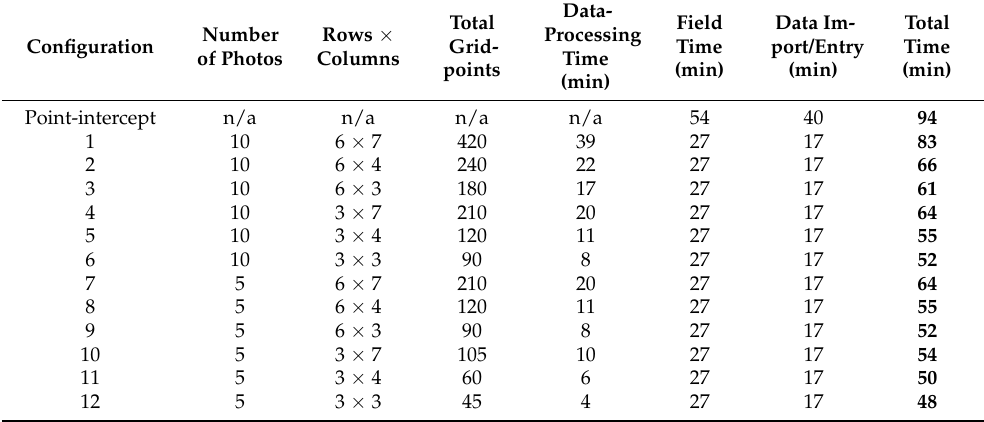
Table 1. Average time to complete vegetation-cover survey by method (point-intercept vs. Photogrid) and by Photogrid configuration (1–12). Configuration 1 is the most detailed photo survey containing 420 gridpoints per plot, and configuration 12 is the least detailed with only 45 gridpoints. Point- intercept surveys (top row) have no Photogrid classification as percent cover was derived by a point-intercept survey in the field. All time data represent means from 13 field plots surveyed by both Photogrid and point-intercept methods in the spring of 2019 in various vegetation types. Data- Total Number Rows × Configuration Grid- of Photos Columns points